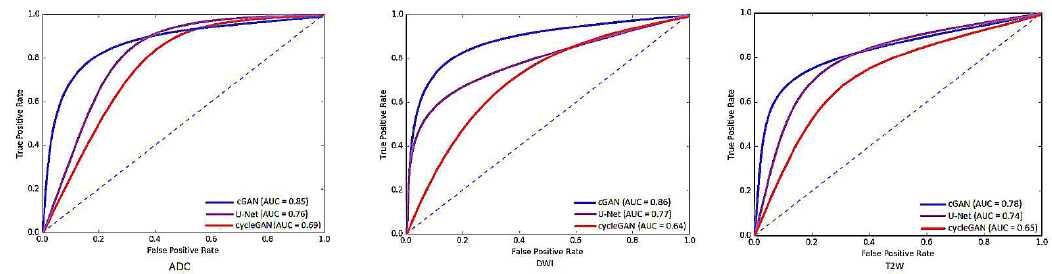
Figure 7. The ROC curves and AUC values for different networks used in this study applied to three modalities (ADC, DWI and